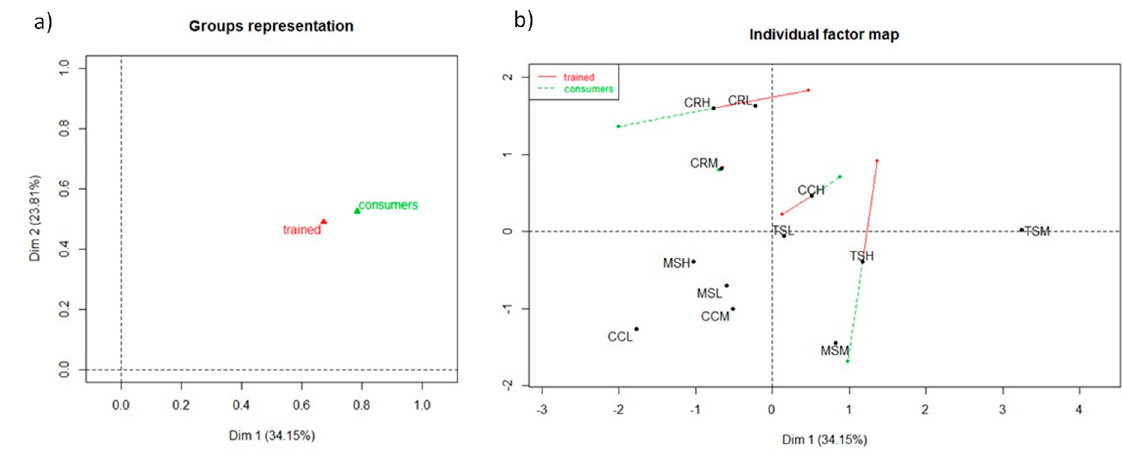
Figure 2. Differences in evaluating the astringency subqualities by CATA between trained assessors and consumers of Sangiovese wines (MS: Morellino di Scansano; TS: Toscana; CC: Chianti Classico; CR: Chianti Riserva) belonging to low (–L), medium (–M), and high (–H) price range, through the Multiple Factor Analysis (( a ), groups representation; ( b ), individual factor map).